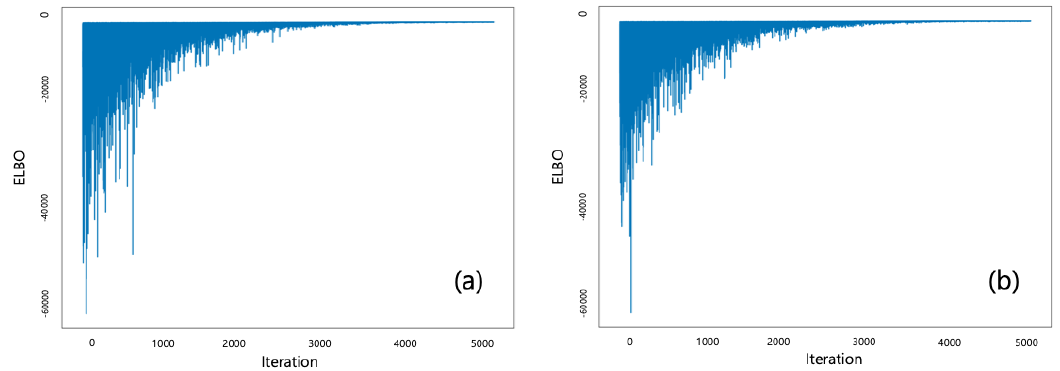
Figure 9. Evidence lower bound for tsunamis in ( a ) 1983 and ( b ) 1993 at a mean of